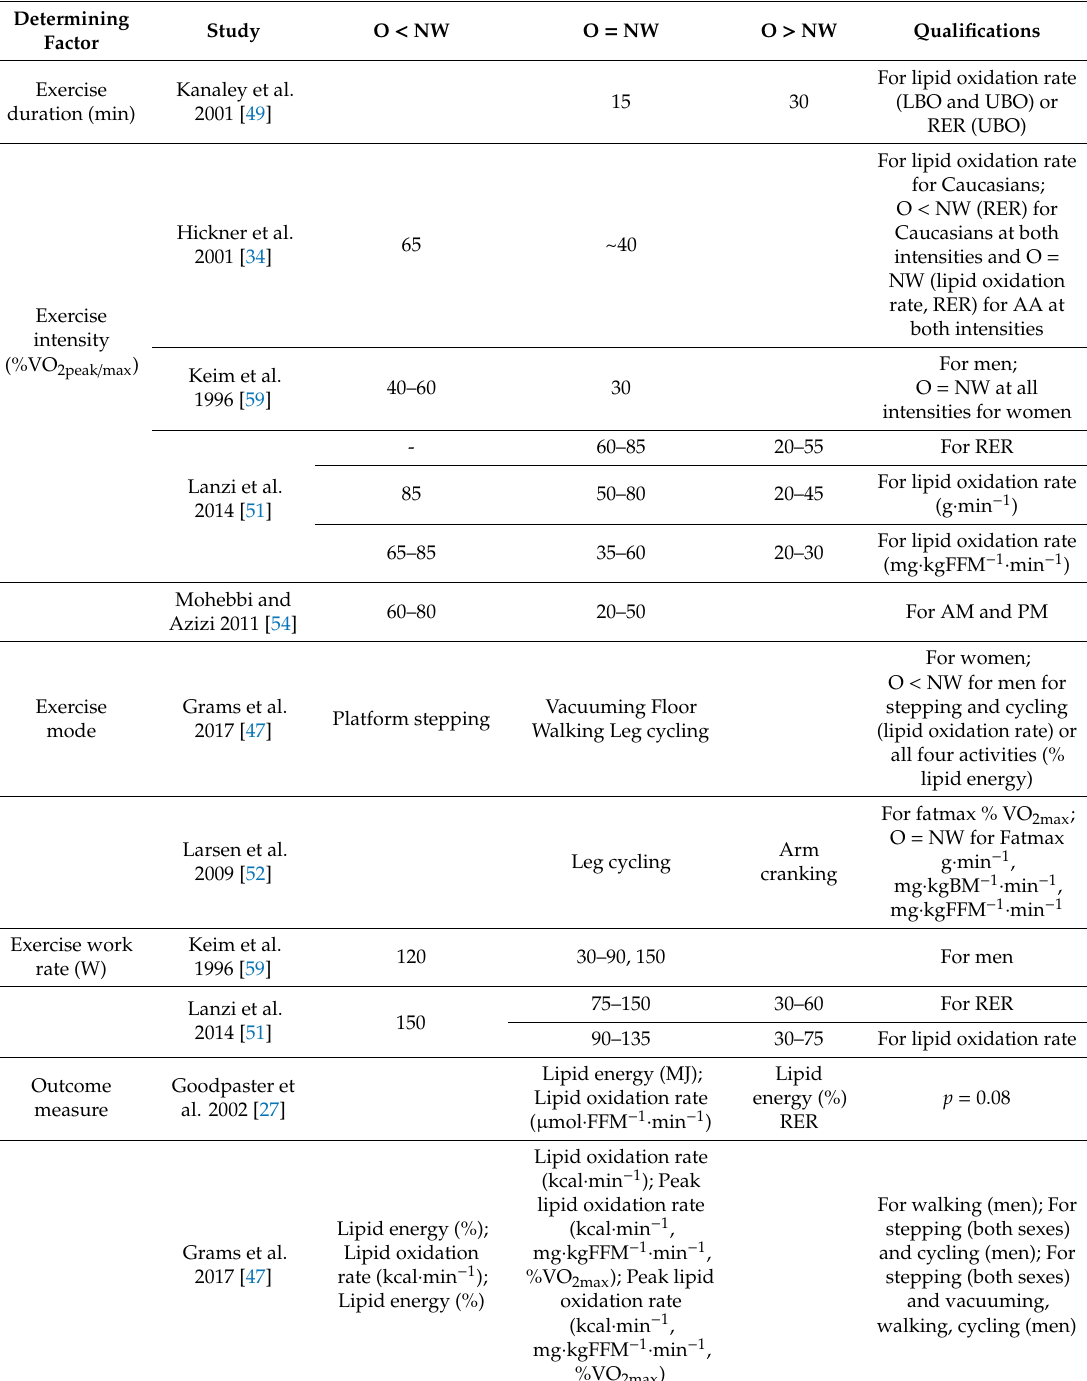
Table 2. Conclusion drawn from eight of 24 included studies that returned equivocal findings based on multiple outcome measures, populations, and / or exercise characteristics that were